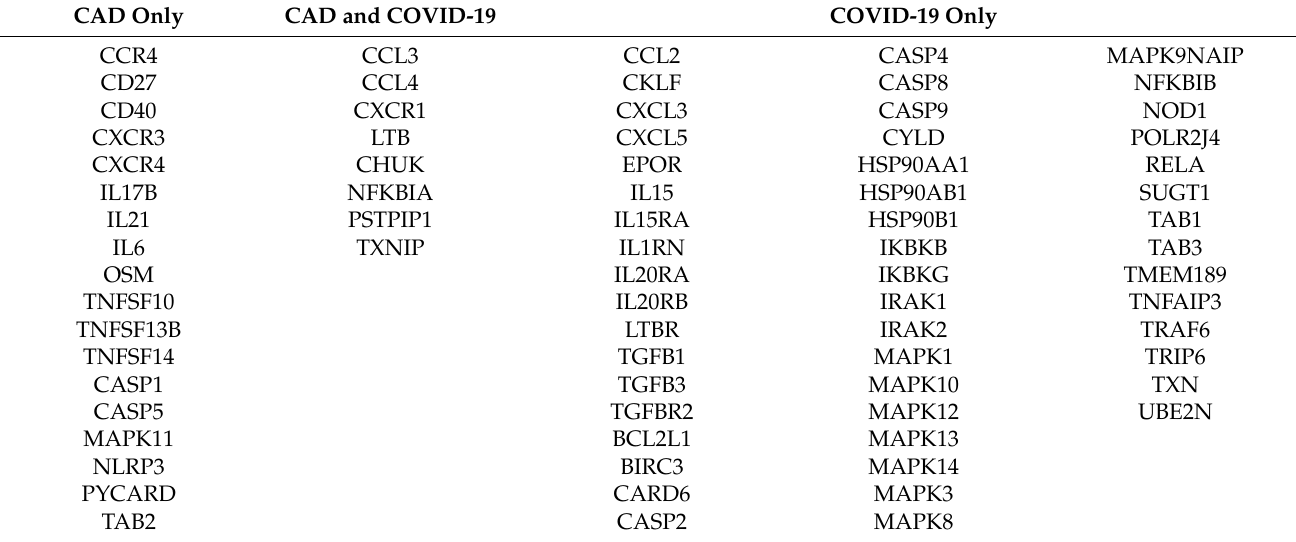
Table A3. Complete list of dysregulated cytokine and inflammasome-related genes. CAD